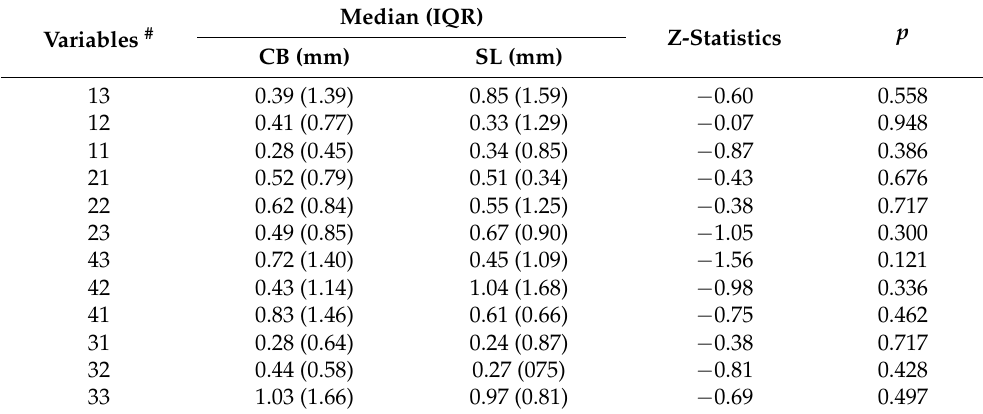
Table 6. Root resorption between CB and SL bracket system regardless of LLLT application.